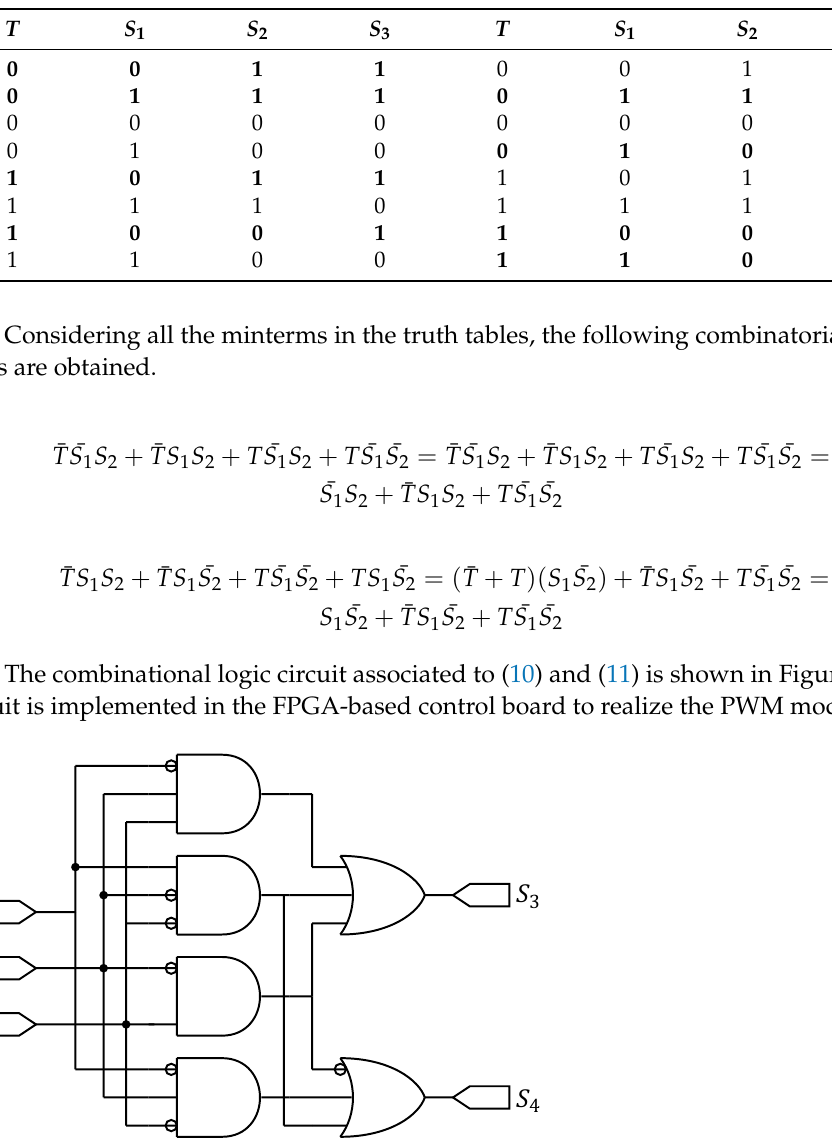
Table 1. Thruth tables of S 3 control signal and S 4 control signal.